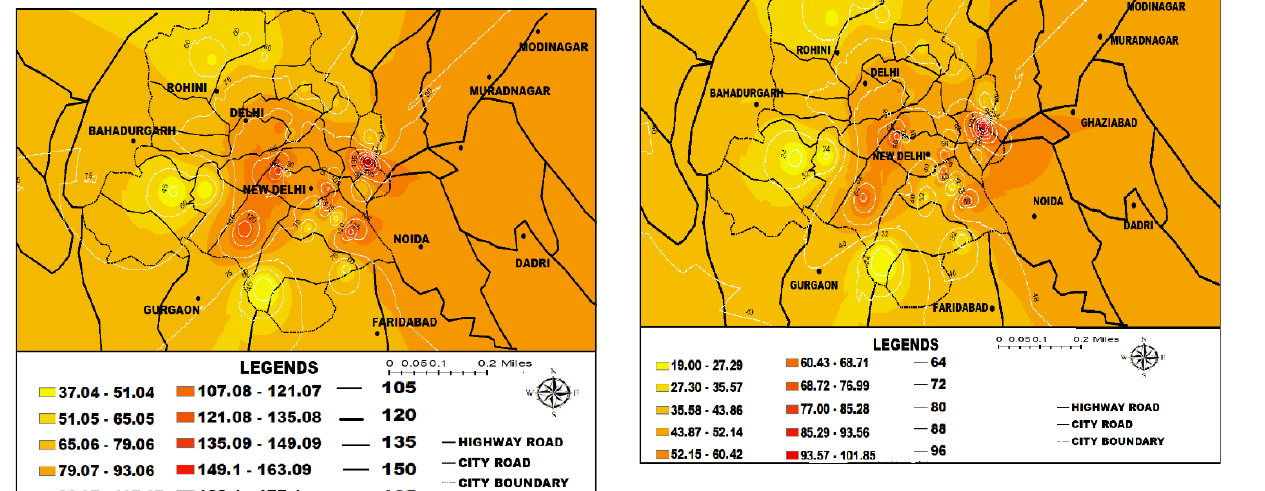
Figure 5. Air quality map of Delhi May monthly average based on NOx (µg/m 3 ).